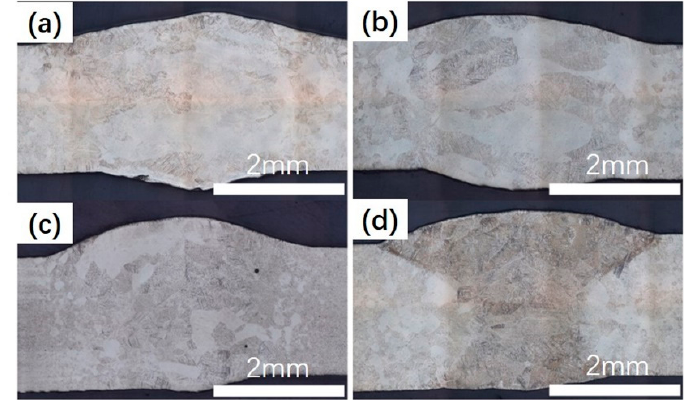
Figure 7. The cross section of welded joints at the different BSGFR; ( a ) 15 L/min; ( b ) 25 L/min; ( c ) 35 L/min; ( d ) 45 L/min.